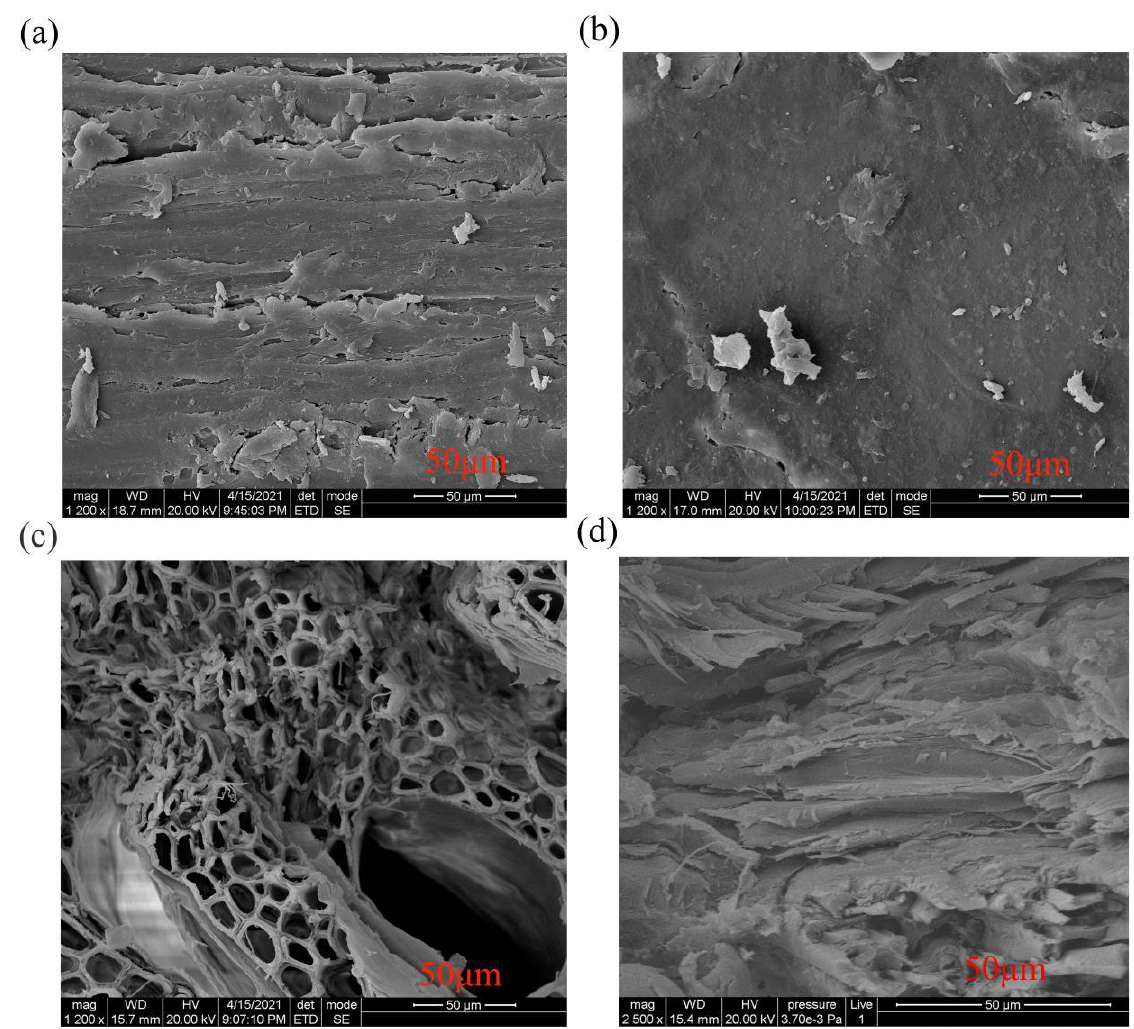
Figure 7. Microscopic images of the cross-section of ( a ) poplar and ( b ) WPC. Microscopic images of the surface of ( c ) poplar and ( d ) WPC.